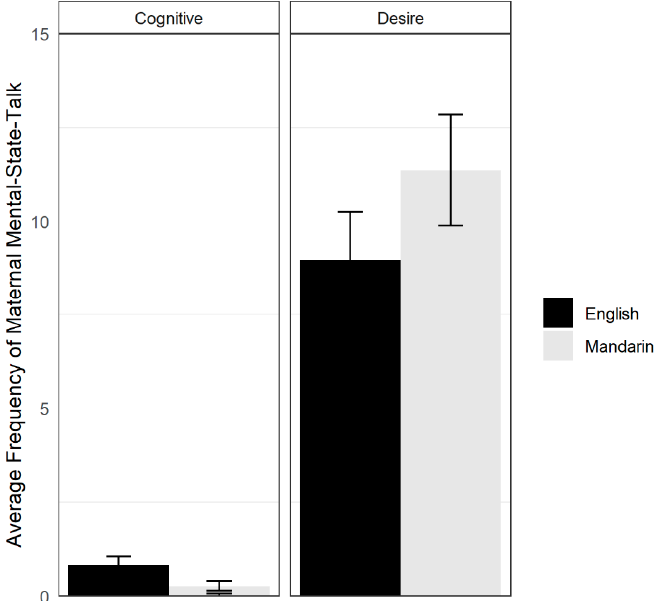
Figure 1. Average frequency of maternal mental-state-talk across languages with error bars representing ±1 standard error of the mean. Average frequency of mothers’ cognitive mental-state-talk is illustrated on left; average frequency of mothers’ desire mental-state-talk is illustrated on right.